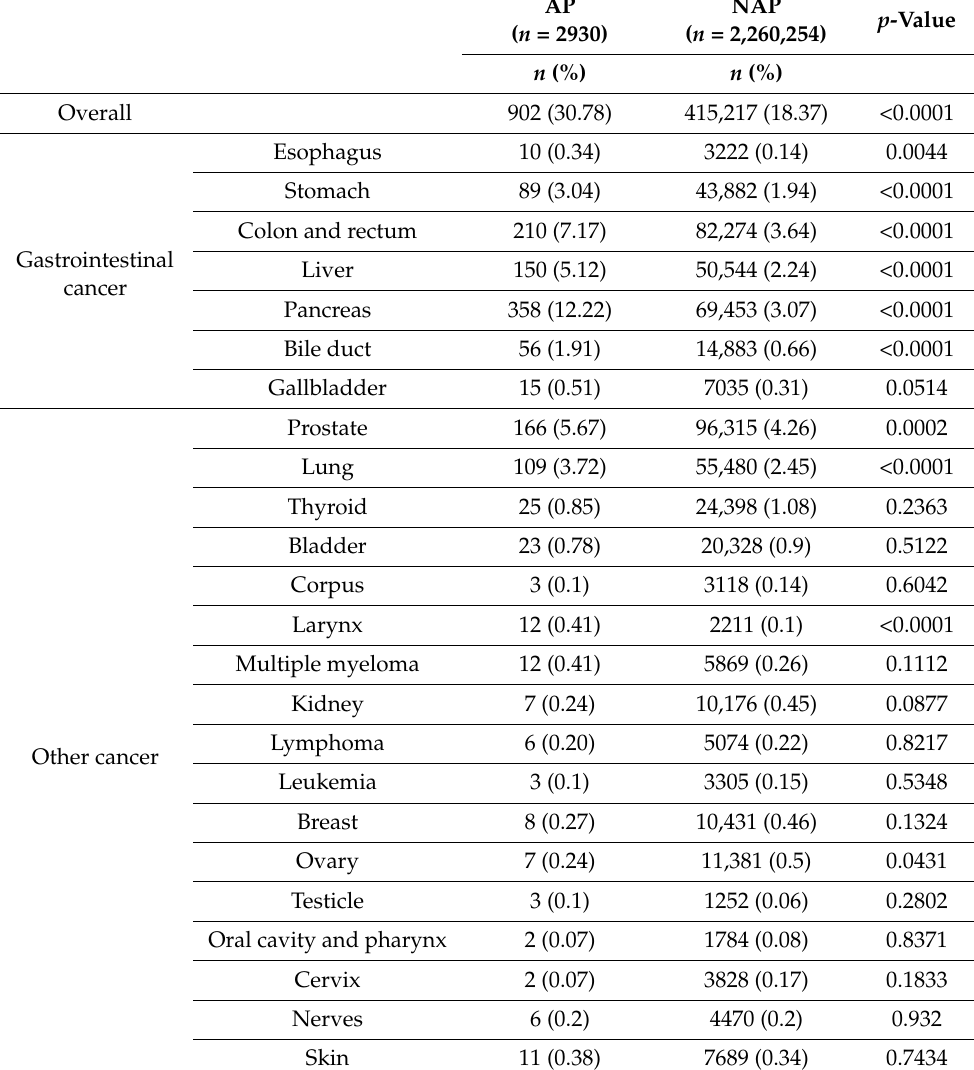
Table 2. Cancer incidence in diabetic patients according to history of acute